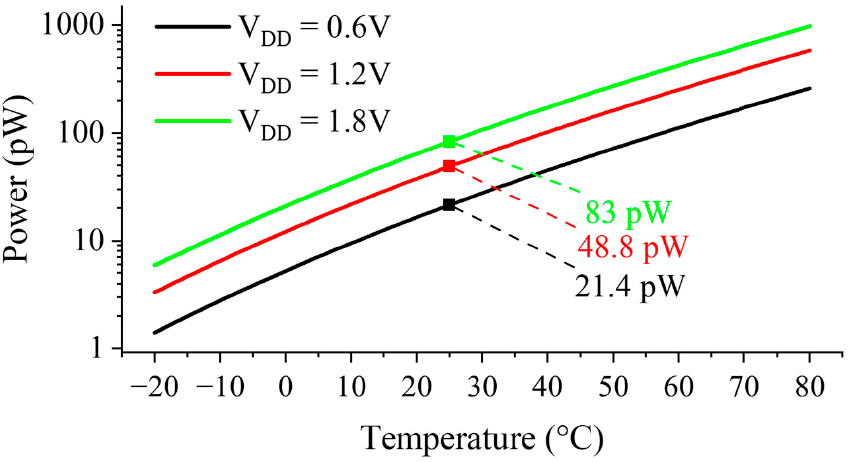
Figure 13. Simulated power consumption.